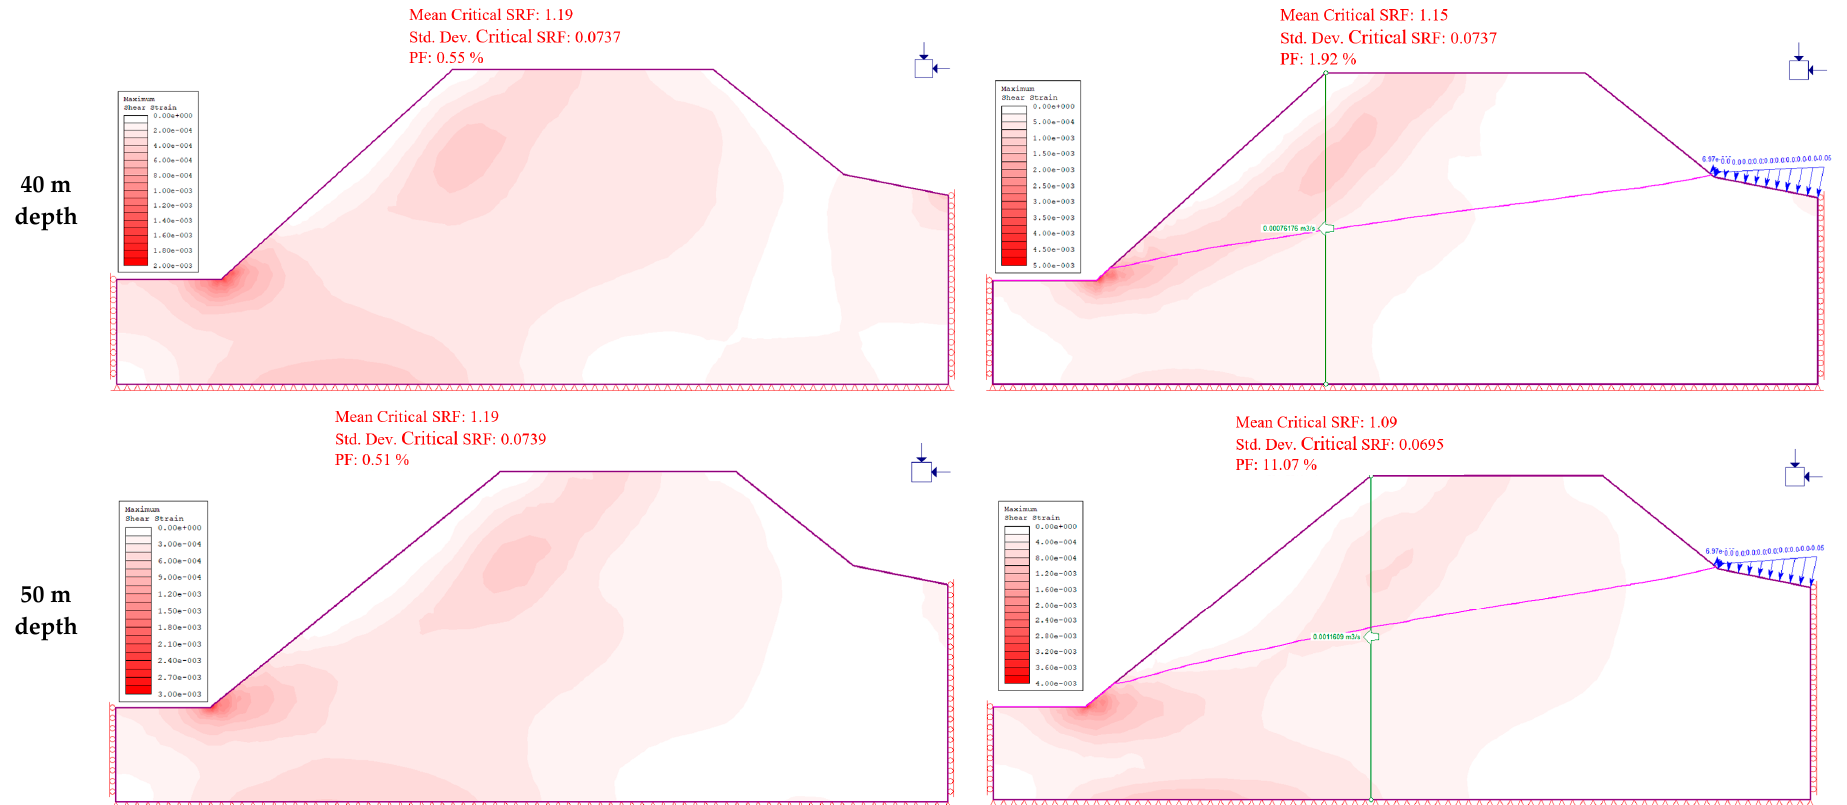
Figure 13. Changes in slope safety factor at 75 m from the shoreline.